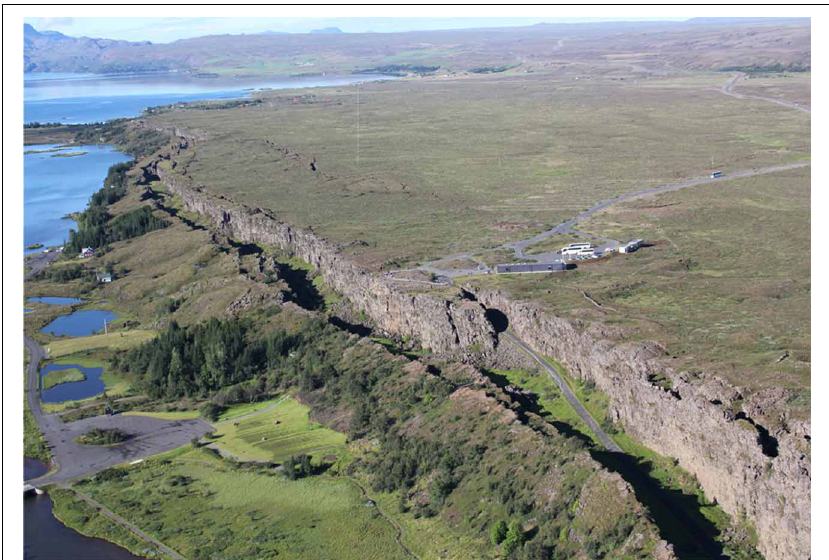
FIGURE 1 | Plate-tectonic driving forces. We can estimate the stresses needed to form a fault at a divergent plate boundary, such as here, but we do not know how the forces that cause those stresses and move the plates. Aerial view southwest, part of a large mixed-mode (opening and vertical displacement) normal fault in a Holocene pahoehoe lava flow of the rift zone in Southwest Iceland. The maximum opening of the fault is about 60m. Buses and houses provide a